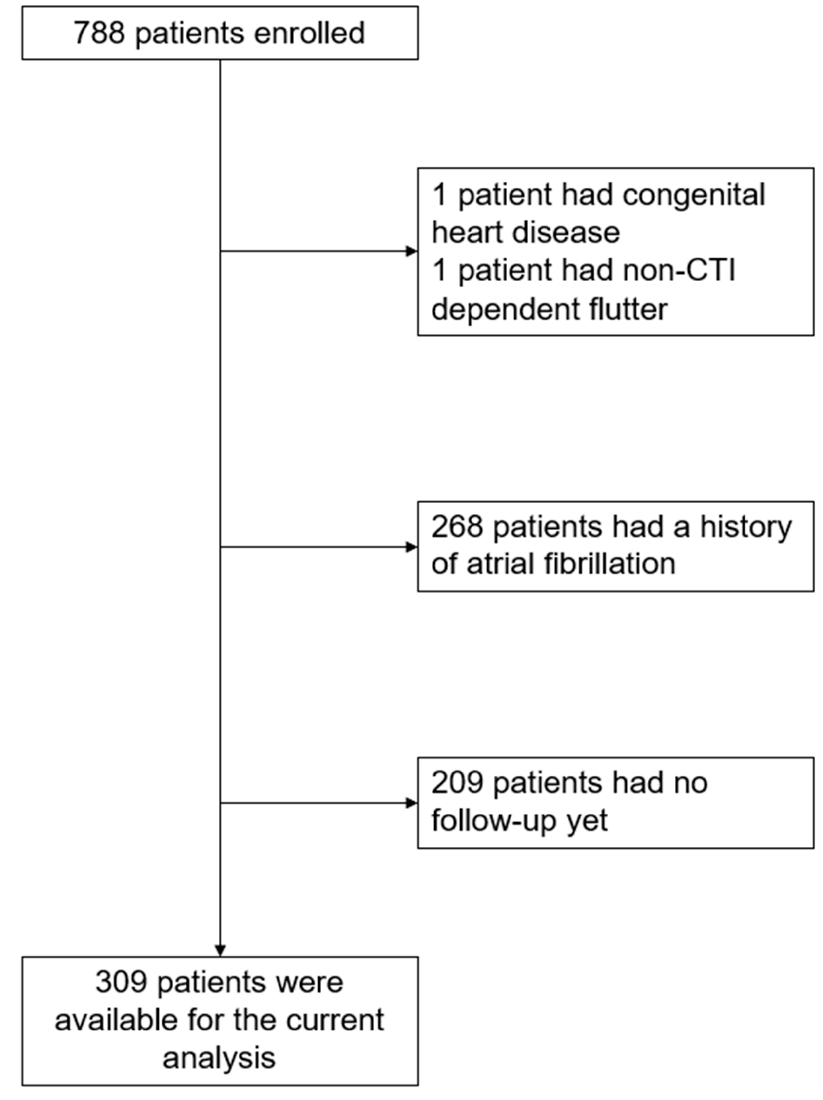
Figure 1. Study flow. CTI: cavotricuspid-isthmus